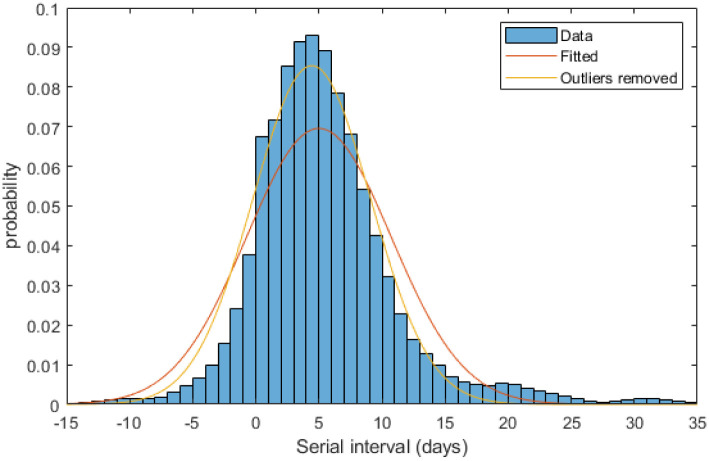
Serial interval distribution with fitted distributions.Red curve shows the normal distribution fitted to all data (~N(μ = 5.0, σ = 5.7)); yellow curve shows the normal distribution fitted to data excluding serial intervals longer than 20 days (~N(μ = 4.4, σ = 4.7)).